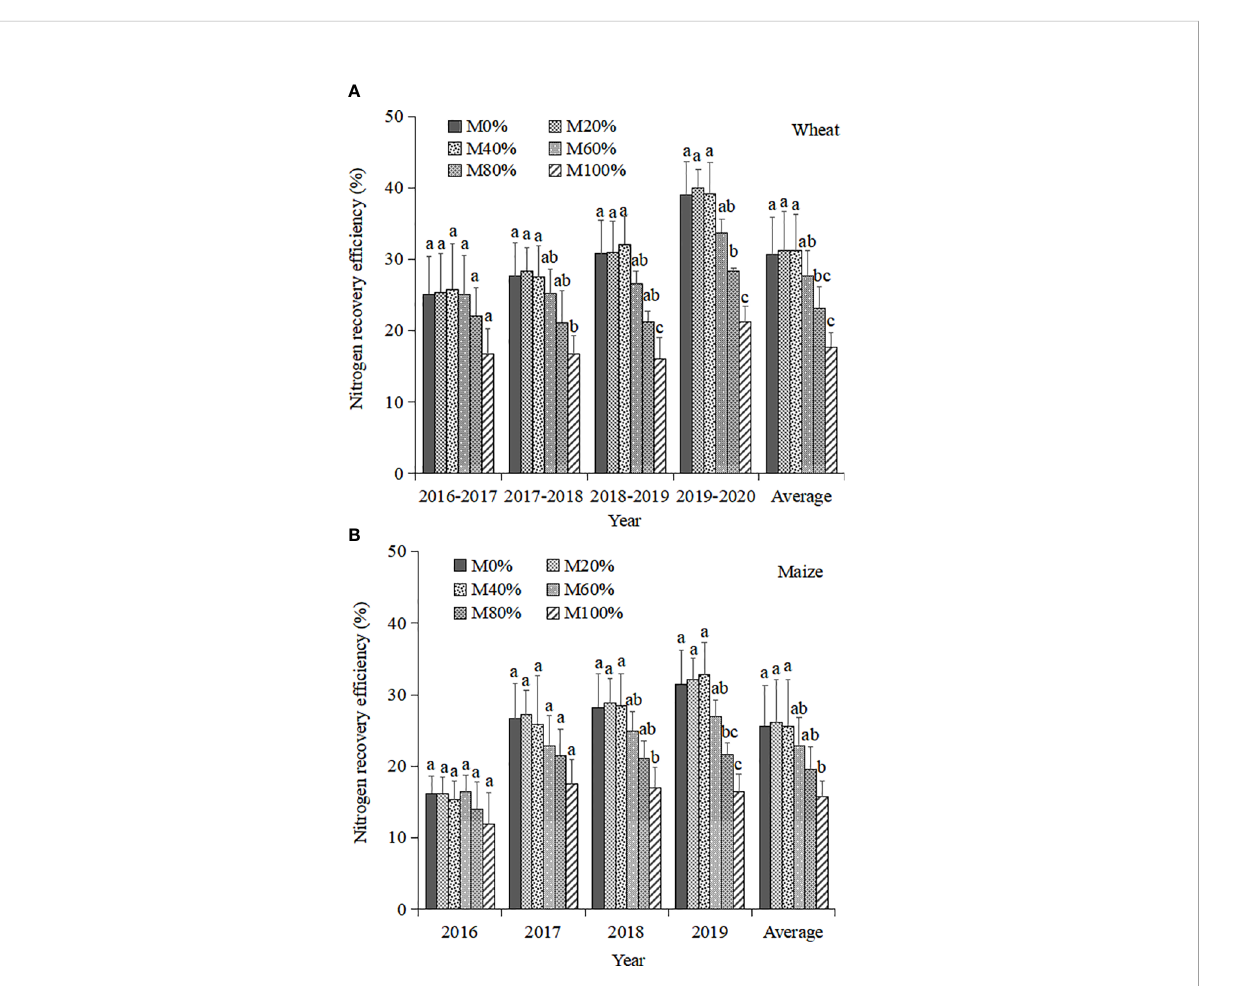
FIGURE 1 Nitrogen recovery ef fi ciency of wheat (A) and maize (B) under treatments with different ratios of chicken manure substitution for mineral nitrogen